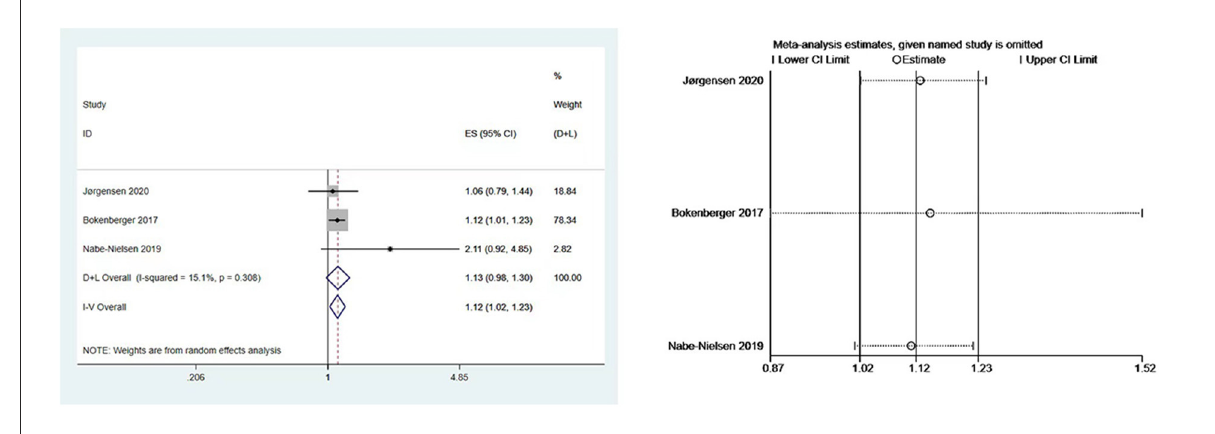
FIGURE3 Forest plot and sensitivity analysis of the relationship between night work and dementia risk.